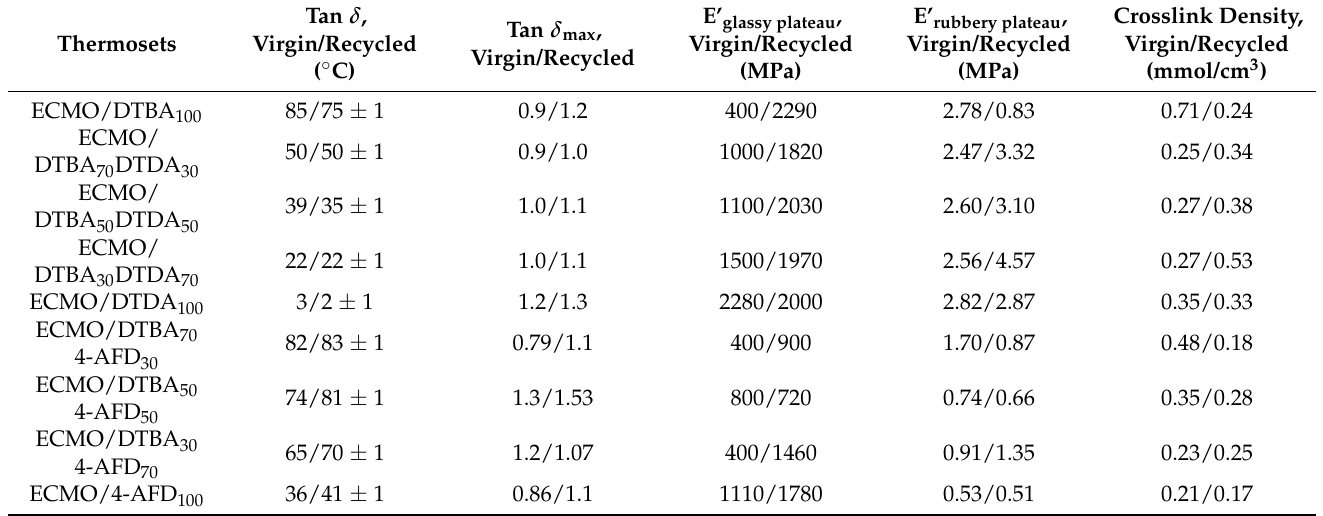
Figure 6. DMA curves of tan δ and storage moduli vs. temperature for the virgin or recycled thermosets based on ECMO cured with: ( A ) and ( C ) DTBA x DTDA y ; ( B ) and ( D ) DTBA x 4-AFD y . Table 2. Thermomechanical properties of the virgin and reprocessed resins .